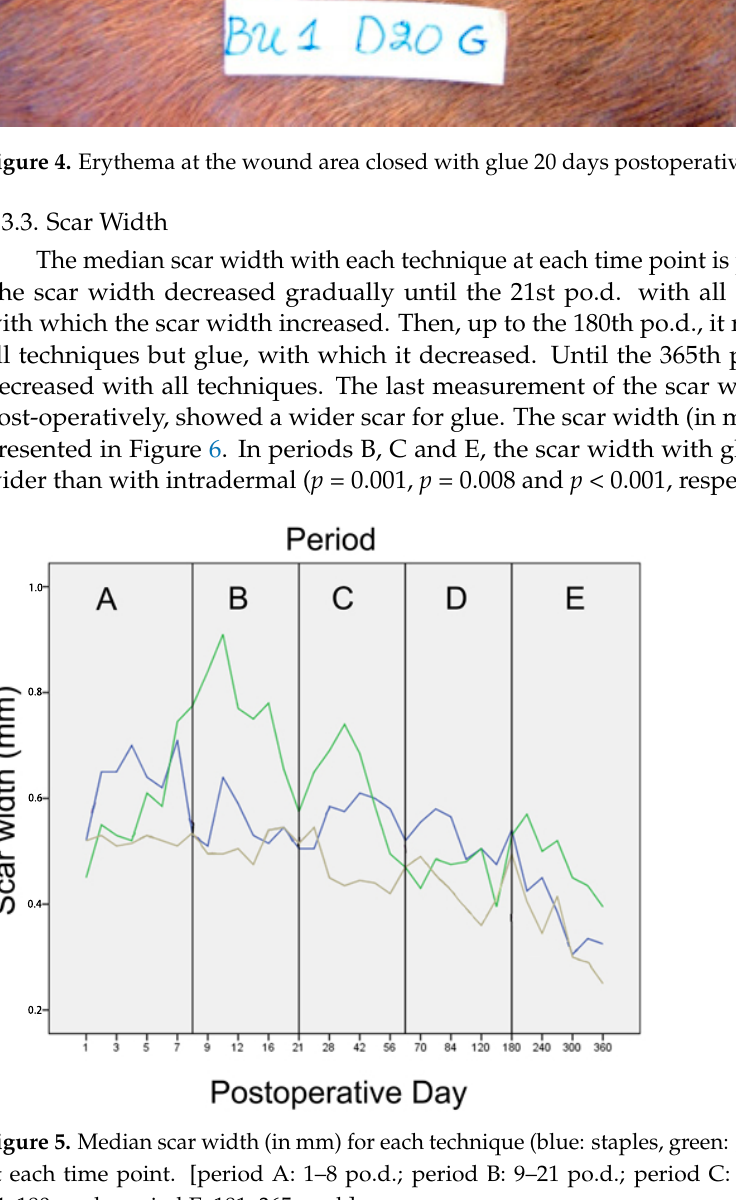
64–180 po.d.; period E: 181–365